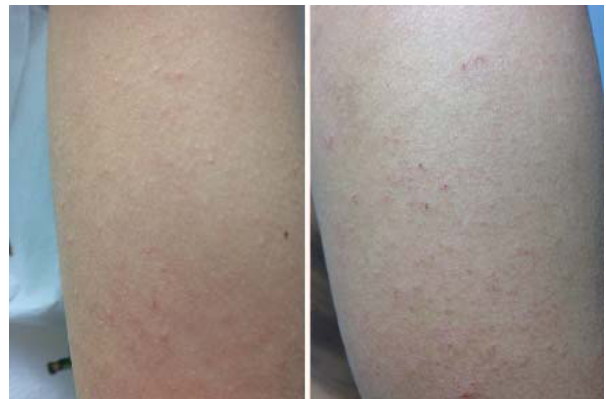
Figure 22. Keratosis